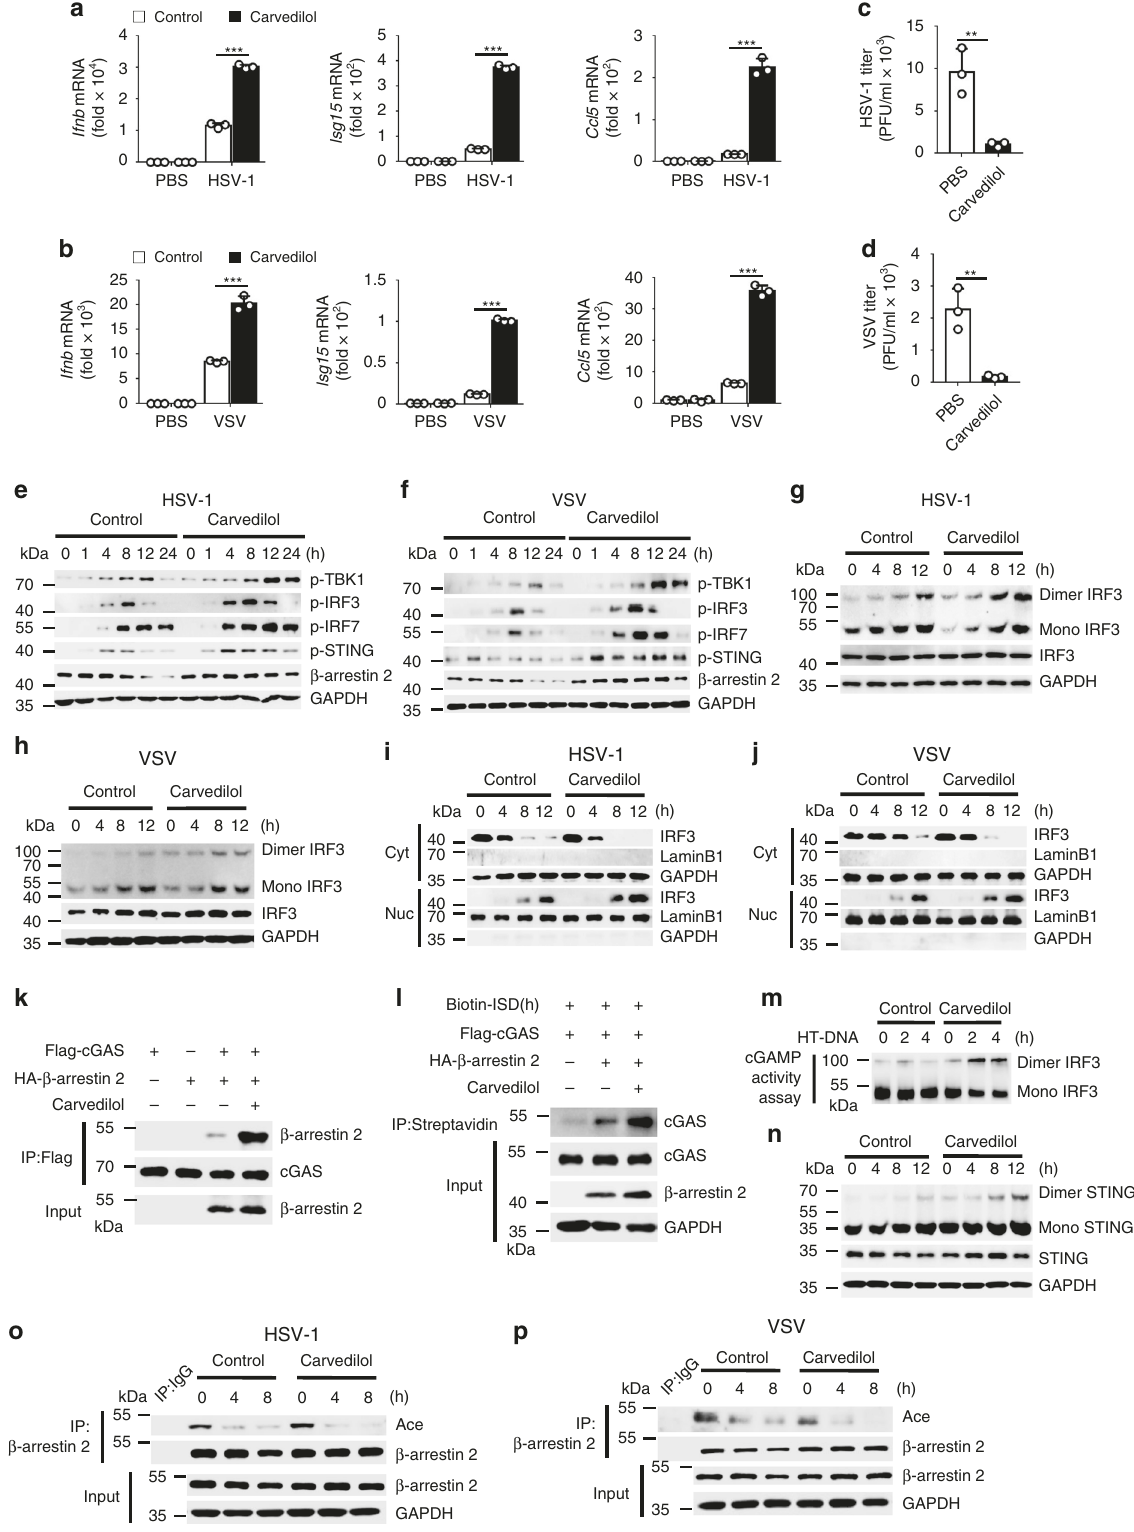
GST pull-down . His or GST fusion proteins were expressed in BL-21(DE3) (Tiangen Biotech) according to the manufacturer ’ s instructions. GST fusion pro- teins were lysed by ultrasonication, incubated with GST beads for 4 h at 4°C, and then washed three times with TBST to collect the precipitates. Puri fi ed His fusion protein or lysates of mouse peritoneal macrophages were incubated with